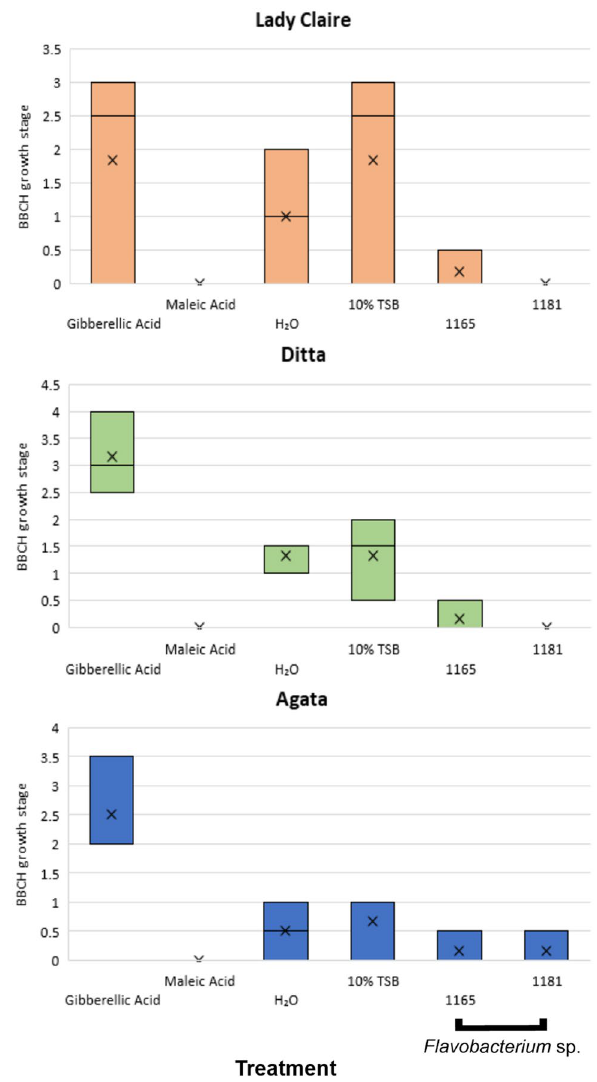
Figure 4. In vitro potato tuber sprouting assay results. Tuber buds of three different varieties (Lady Claire, Ditta and Agata) were treated with two different isolates of Flavobacterium sp. (AIT1165 and AIT1181). For evaluation, bud growth was assessed according to the first principal growth stages of the BBCH scale. Hereby, the first stage 00 is considered innate or enforced dormancy with no sprouting at all, followed by stages 01 and 02, which represent the beginning of sprouting when sprouts are visible with sizes up to < 1 mm and 2 mm, respectively. According to the BBCH scale, dormancy is broken at stage 03. When tuber buds treated with maleic hydrazine reached stage 01, the assay was ended, and the sum of all growth stages of each replicate was calculated. Afterwards, the average of two repetitions was visualized in a boxplot diagram. The boxplot diagram shows that treatments with both isolate cultures led to sprouting inhibition in comparison to the assay control. The assay control gibberellic acid represents an effective sprouting promoter, whereas maleic hydrazine was used as the negative control. Ten percent tryptic soy broth (used as the medium for culture of the isolates) and sterile water were used as neutral